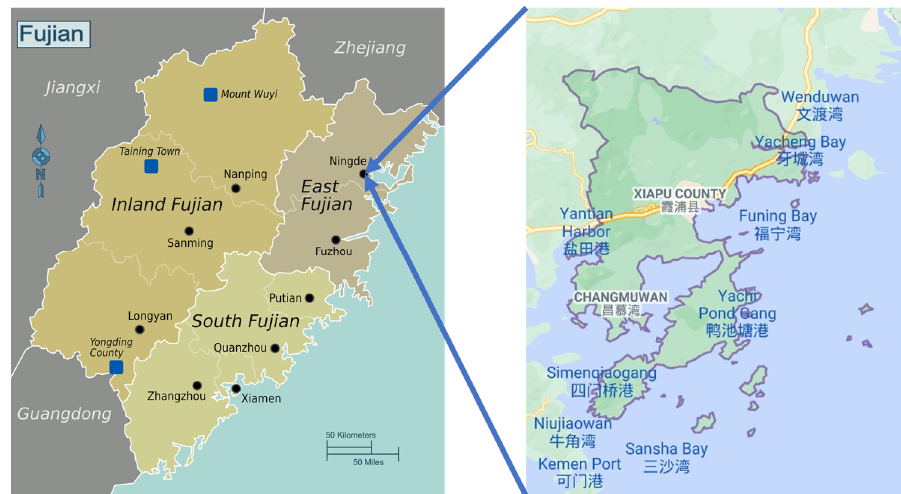
Figure 1. Map of Xiapu County. (retrieved from https://en.wikivoyage.org/wiki/File:Fujian_map.png accessed on 14 February 2022 and https://www.google.com/maps accessed on 14 February 2022.).